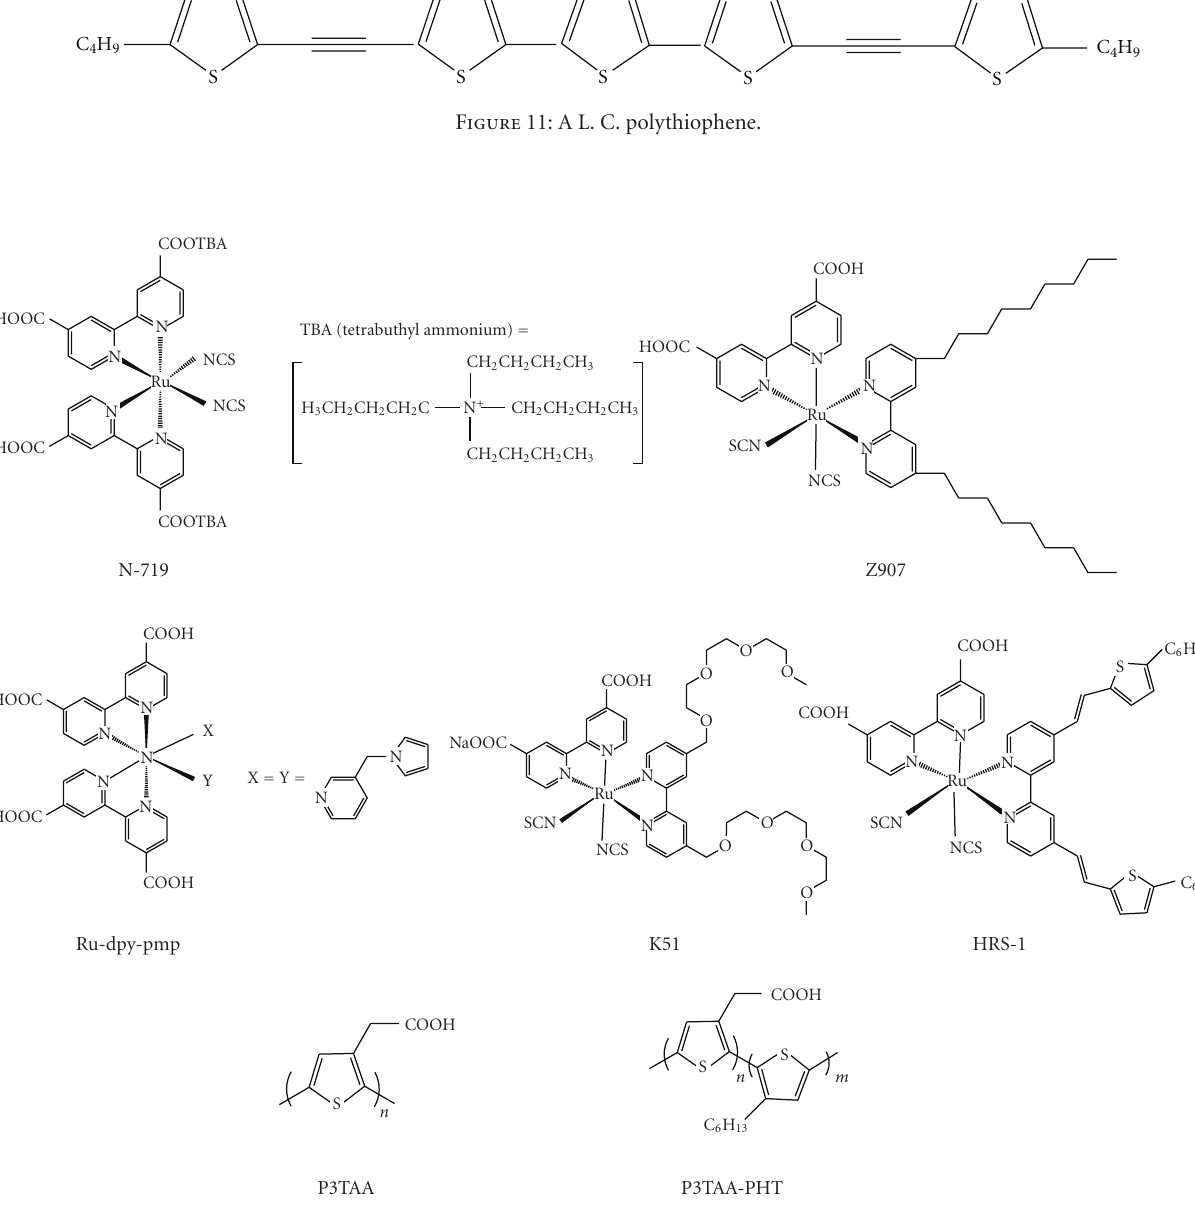
Figure 11: A L. C. polythiophene.